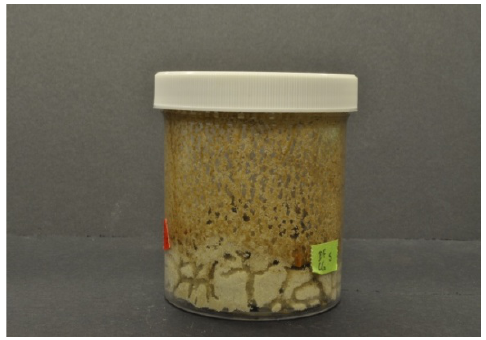
Figure 2. Tunnel network of C. gestroi .